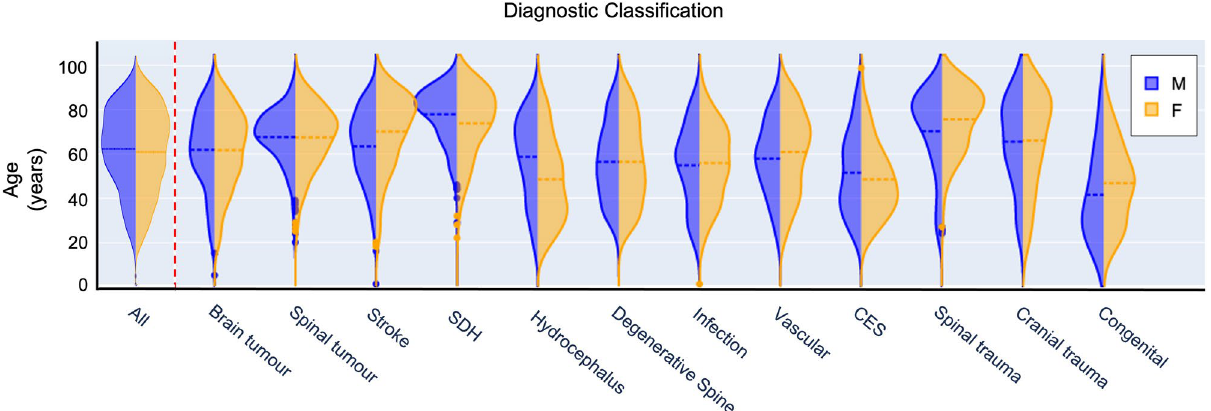
Figure 2. Age and sex distribution of referrals presented by diagnostic classification ( SDH subdural hemorrhage, M male, F